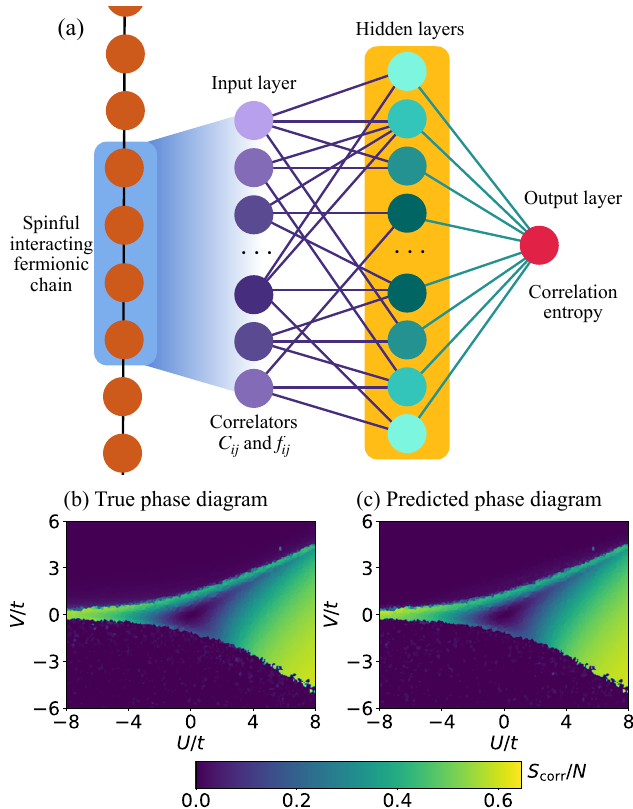
Figure 1: The neural-network structure and the phase diagram of the correlation entropy. (a) Schematic of a one-dimensional interacting fermionic system, where a set of local measurements allow extracting the correlation entropy through a trained neural-network algorithm. (b) The UV -phase diagram of the correlation entropy. (c) The neural-network model predicted the UV -phase diagram of the correlation